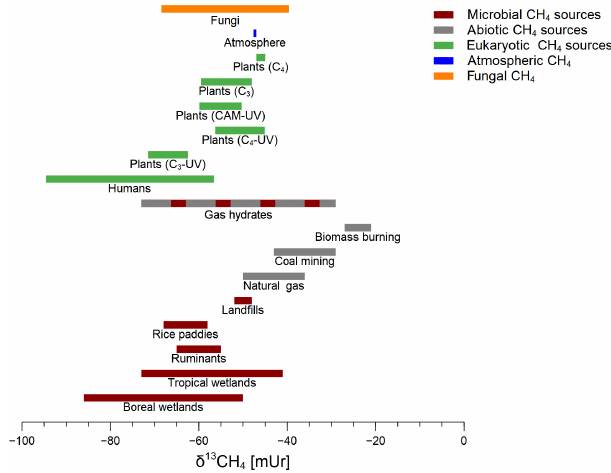
Figure 5. The range of δ 13 C-CH 4 values of microbial CH 4 sources (red), abiotic CH 4 sources (grey), eukaryotic CH 4 sources (green), atmospheric CH 4 (blue), and fungal CH 4 from this study (orange). The red and grey dashed bar indicates a mixture of microbial and abiotic CH 4 formation processes for gas hydrates (Kvenvolden, 1995). Data were taken from Brownlow et al. (2017), Keppler et al. (2006, 2016), Kvenvolden (1995), Nisbet et al. (2016), Quay et al. (1999), and Vigano et al.